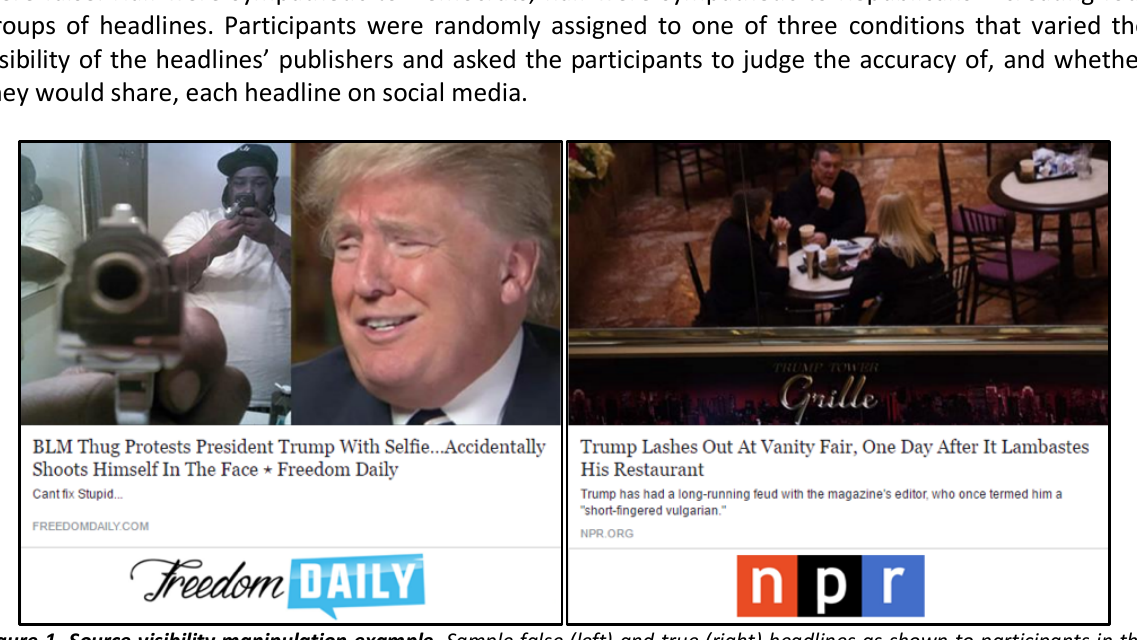
Figure 1. Source visibility manipulation example. Sample false (left) and true (right) headlines as shown to participants in the logo-banner condition of Studies 1 and 2. In the no-source condition, neither the grey-text domain nor the logo banner was shown. In the Facebook baseline condition, only the grey-text domain was